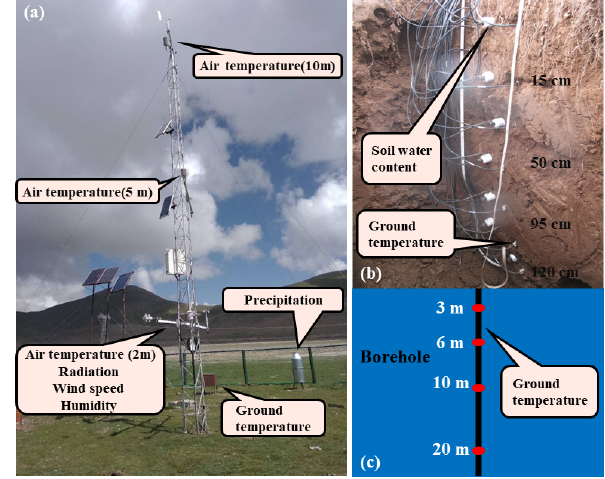
Figure 3. The comprehensive observation system: (a) meteorologi- cal observation, (b) ground temperature and soil water content in the active layer, and (c) ground temperature observation for